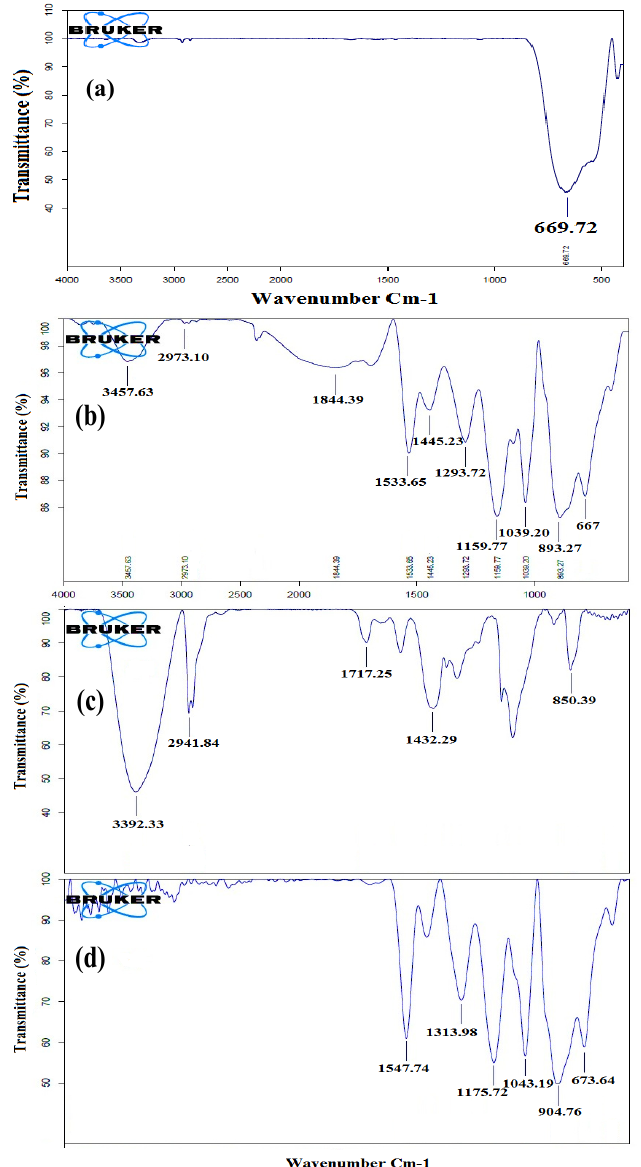
Fig. 4: FTIR spectra of (a) titanium dioxide nanoparticles (b) polypyrrole/titanium dioxide, (c) pure PVA and (d) polypyrrole/titanium dioxide (with